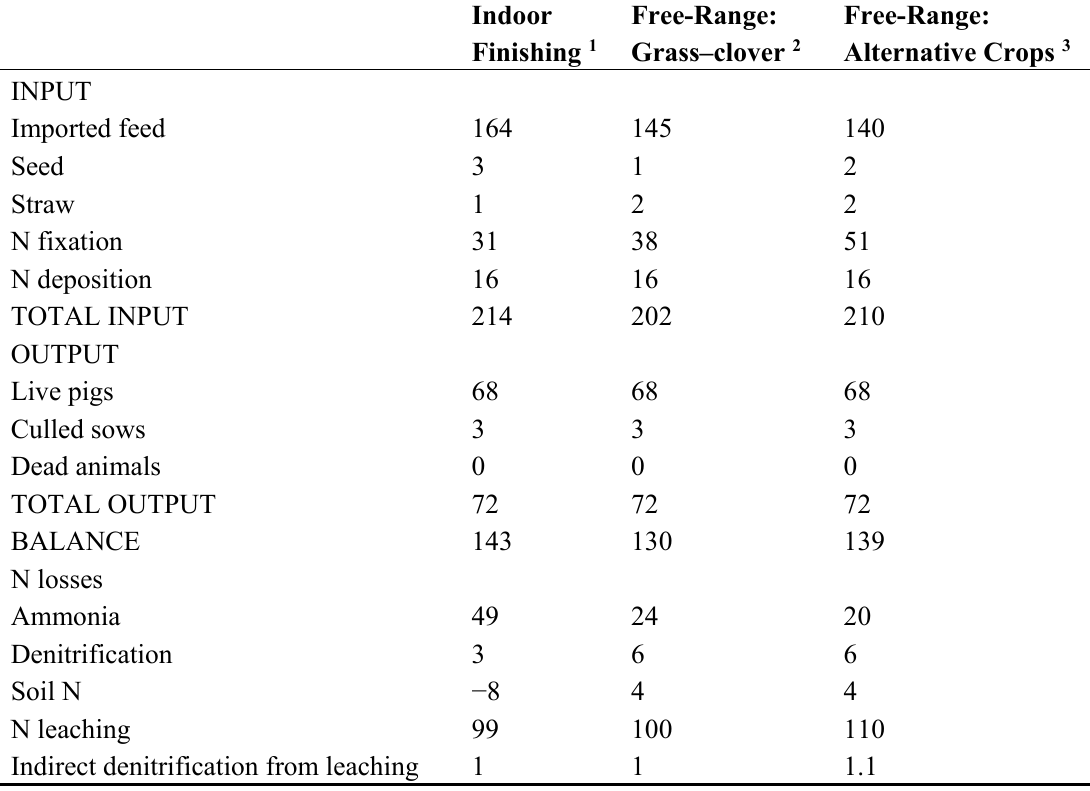
Table 6. Farm N balance (kg N ha −1 ) in three organic pig production